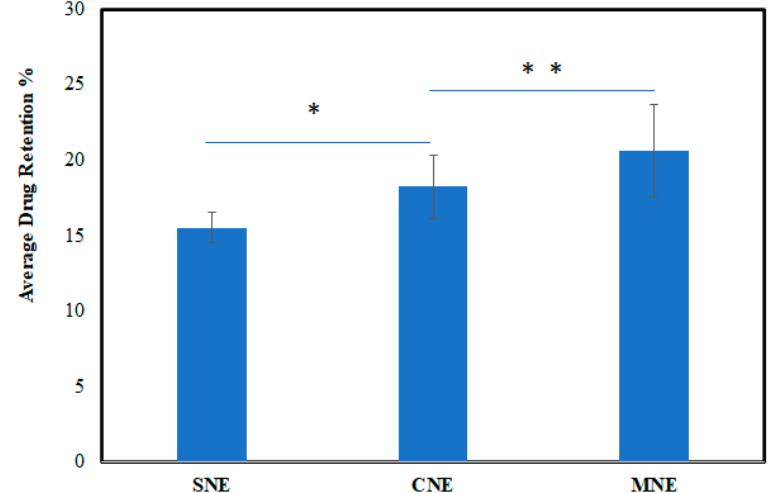
Figure 6. Drug retention profiles of formulated nanoemulsions . Data were expressed as mean ± SD, n = 3, (ANOVA; p <